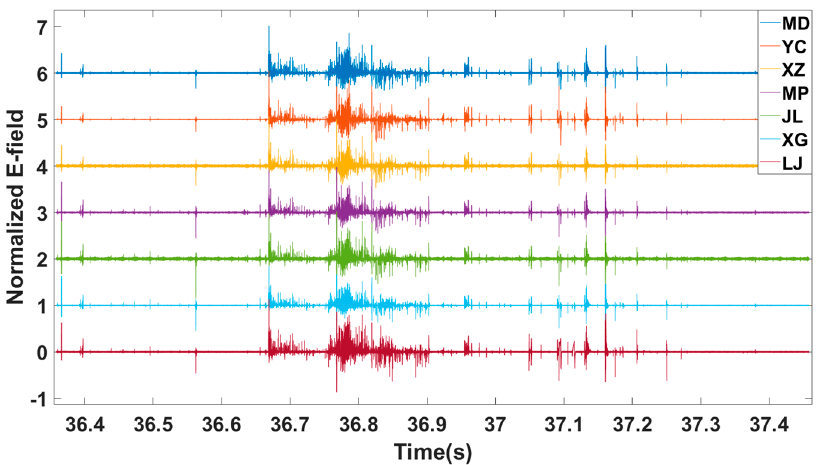
Figure 4. Normalized electric field signal over time from the seven stations for IC flash 001136.